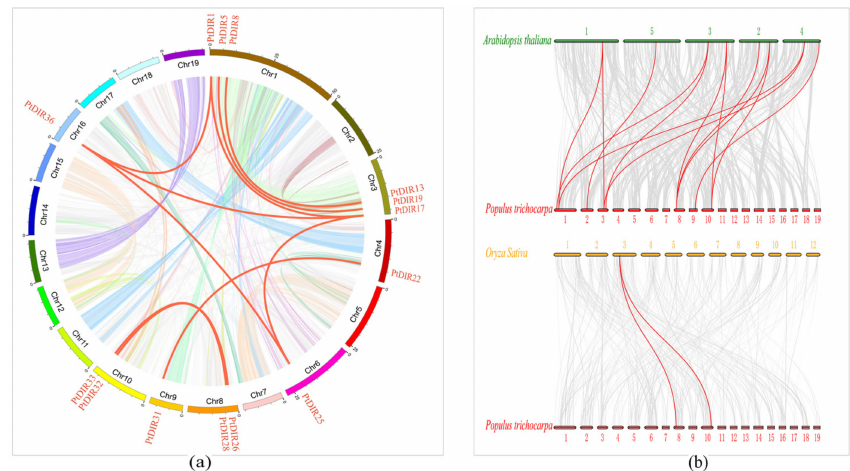
Figure 6. Synteny analysis of PtDIRs. ( a ) Schematic representations of the interchromosomal rela- tionships of PtDIRs. The red lines indicate duplicated PtDIR gene pairs. ( b ) Synteny analysis of DIR genes among Populus, Arabidopsis, and rice. Gray lines in the background show the collinear blocks within P. trichocarpa and other plant genomes; the red lines highlight the syntenic DIR gene pairs.